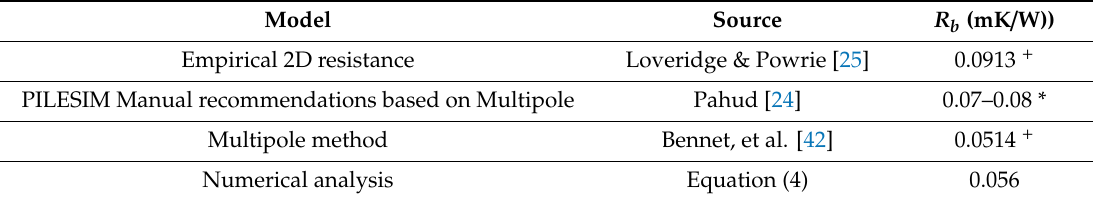
Table 5. Theoretical pile thermal resistance. 2D: two-dimensional.